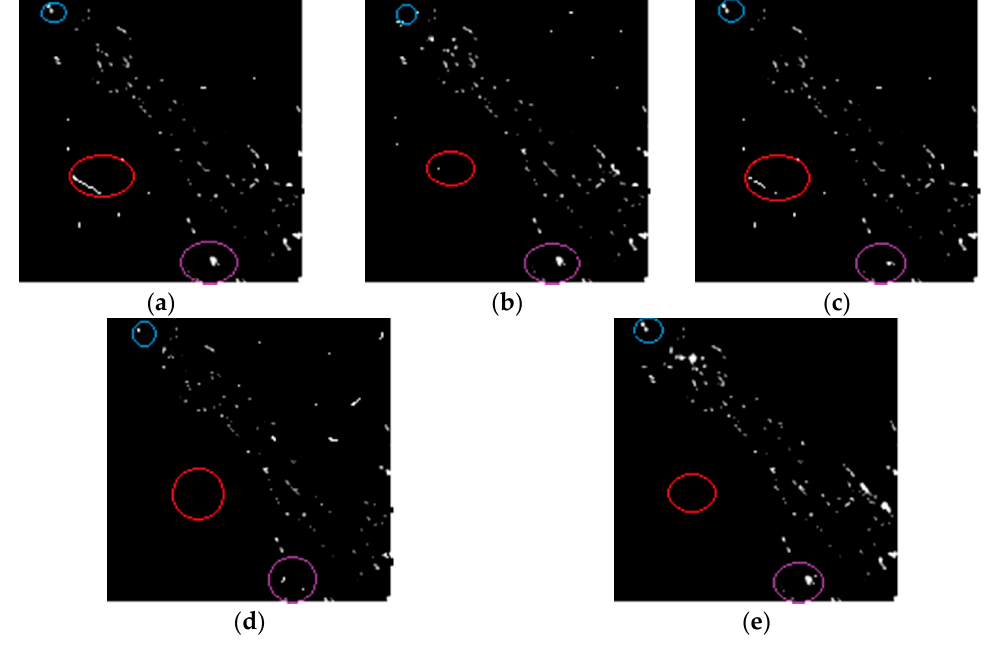
Figure 11. Change detection images obtained for Gurbantunggut data set: ( a ) NSCT-FCM; ( b ) MRF- FCM; ( c ) PA-GT; ( d ) PCA-NLM; ( e ) Proposed algorithm. Table 5. The running time of five algorithms. Table 5. The running time of five